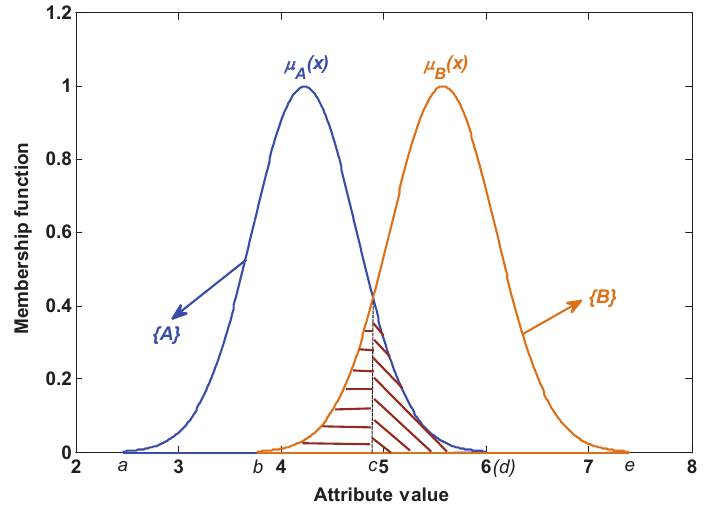
Figure 4. The overlapping area of the static attribute